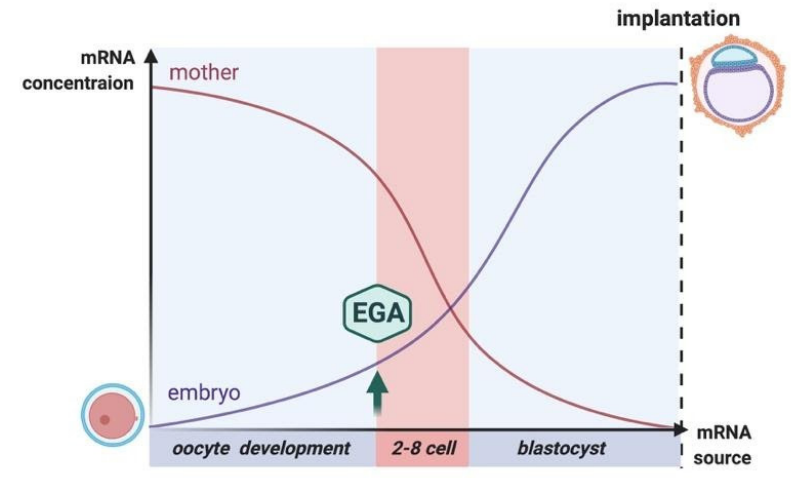
Figure 2. The source and dynamics of mRNA expression during early embryonic